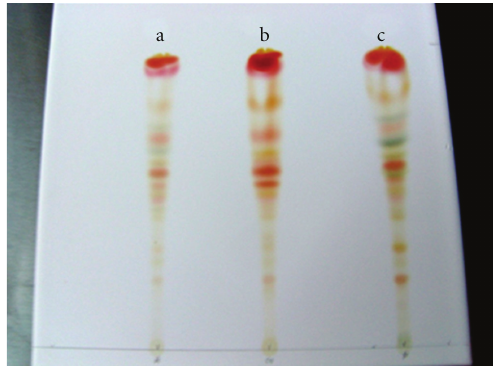
Figure 2: TLC profile of pigments in dried peppers. (a) Ancho pepper, (b) guajillo pepper, (c) pasilla pepper. Ancho and pasilla pepper extracts have green bands, revealing the presence of chlorophylls in these